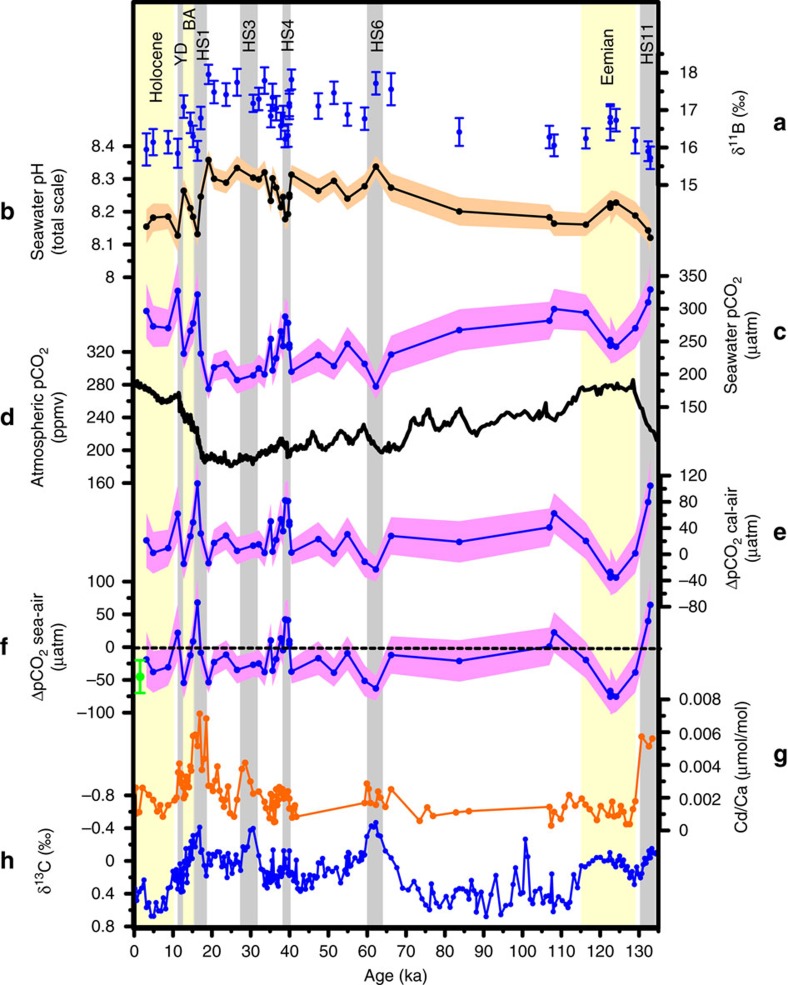
Seawater carbonate chemistry and nutrient reconstructions in sediment core JM-FI-19PC from the Norwegian Sea.(a) δ11B measured in N. pachyderma with analytical uncertainty. (b) seawater-pH inferred from δ11B. (c) estimated seawater pCO2 at the calcification depth and growth season of N. pachyderma. The envelope reflects the uncertainty boundaries based on the propagated error of the individual uncertainties in the parameters used to calculate pCO2. (d) Atmospheric pCO2 from Antarctic ice cores18. (e) the difference between reconstructed shallow subsurface pCO2 at our site and atmospheric pCO2 (ΔpCO2cal-air). (f) ΔpCO2sea-air calculated as ΔpCO2cal-air minus the modern pCO2 gradient between the calcification depth of N. pachyderma (40–200 m water depth) and surface ocean (0–30 m water depth). The green circle indicates present day average ΔpCO2sea-air in the Norwegian Sea21. (g) Cd/Ca measured in N. pachyderma. (h) δ13C measured in N. pachyderma.